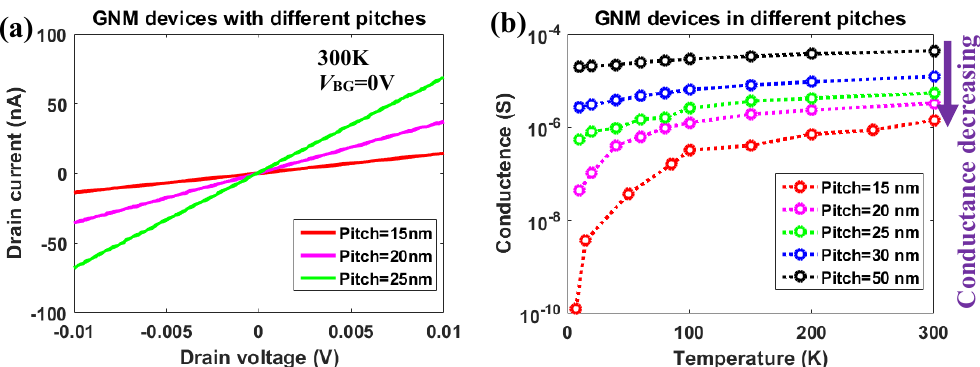
Figure 9. ( a ) The I D − V D characteristics of the GNM devices with di ff erent pitches. ( b ) The conductance results from the linear fitting for the GNM devices with di ff erent pitches from 15 nm to 50 nm. The measurement temperature was from 10 K to 300 K.